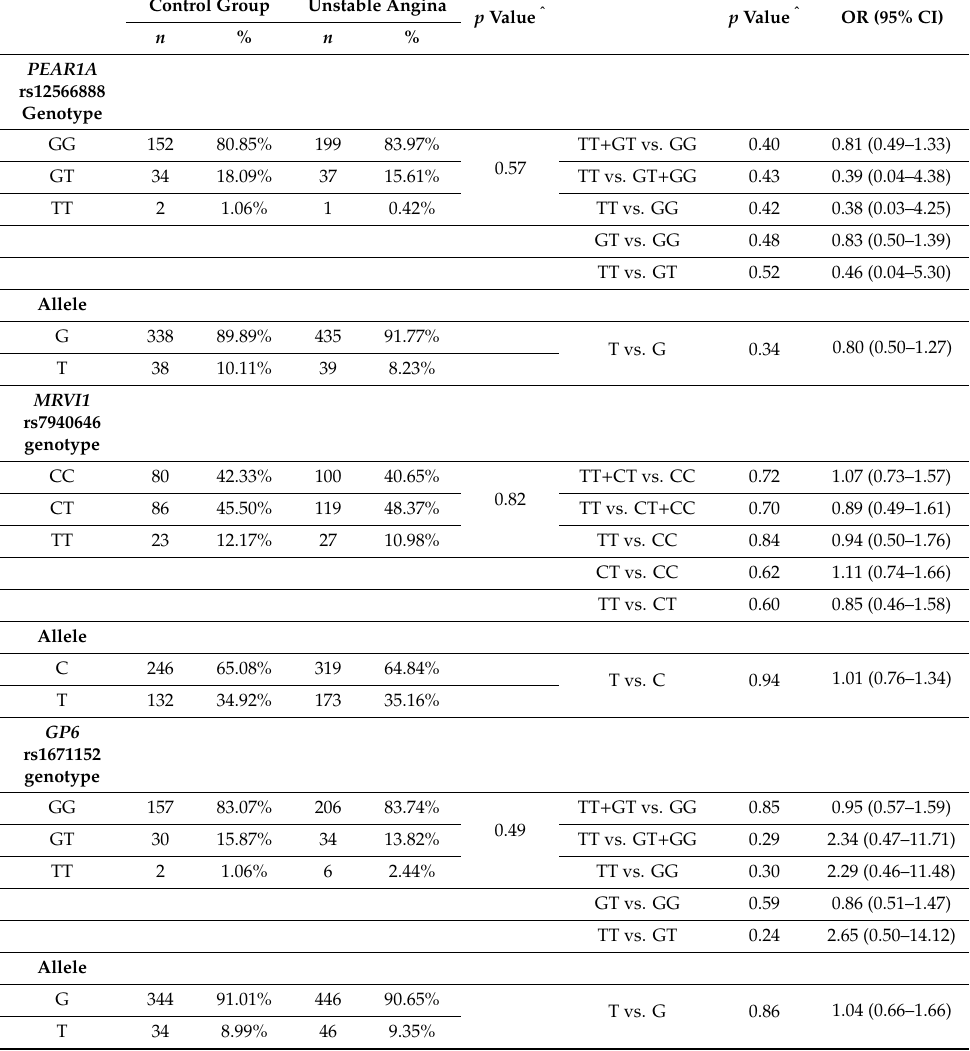
Table 1. Distributions of the PEAR1A , MRVI1 , and GP6 genotypes and alleles in patients with unstable angina and